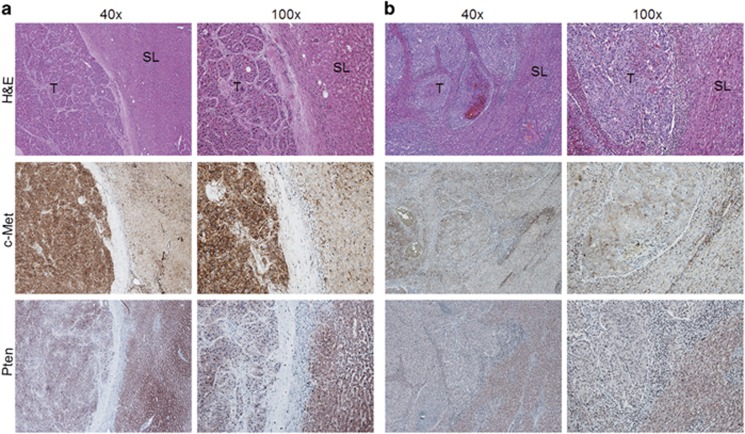
Expression patterns of c-Met and Pten in human hepatocellular carcinoma (HCC) as detected by immunohistochemistry. (a) HCC case showing upregulation of c-Met and downregulation of Pten in the tumor part (T), when compared with non-tumorous surrounding liver (SL). (b) HCC case showing equivalent levels of c-Met immunoreactivity in HCC and adjacent non-tumorous liver, while Pten immunolabeling is higher in the non-neoplastic compartments. Original magnifications: × 40 and × 100. H&E, hematoxylin and eosin staining.